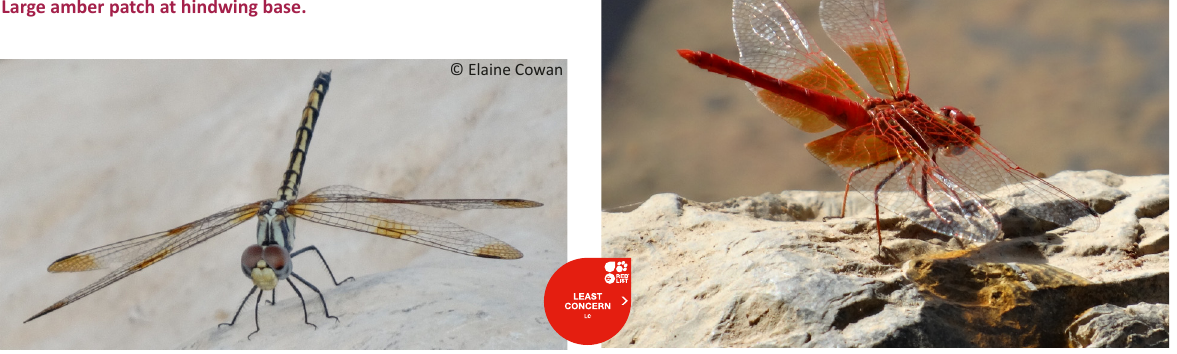
Image 28. Male Trithemis kirbyi , 24 May 2014. Reddish-orange with large orange wing